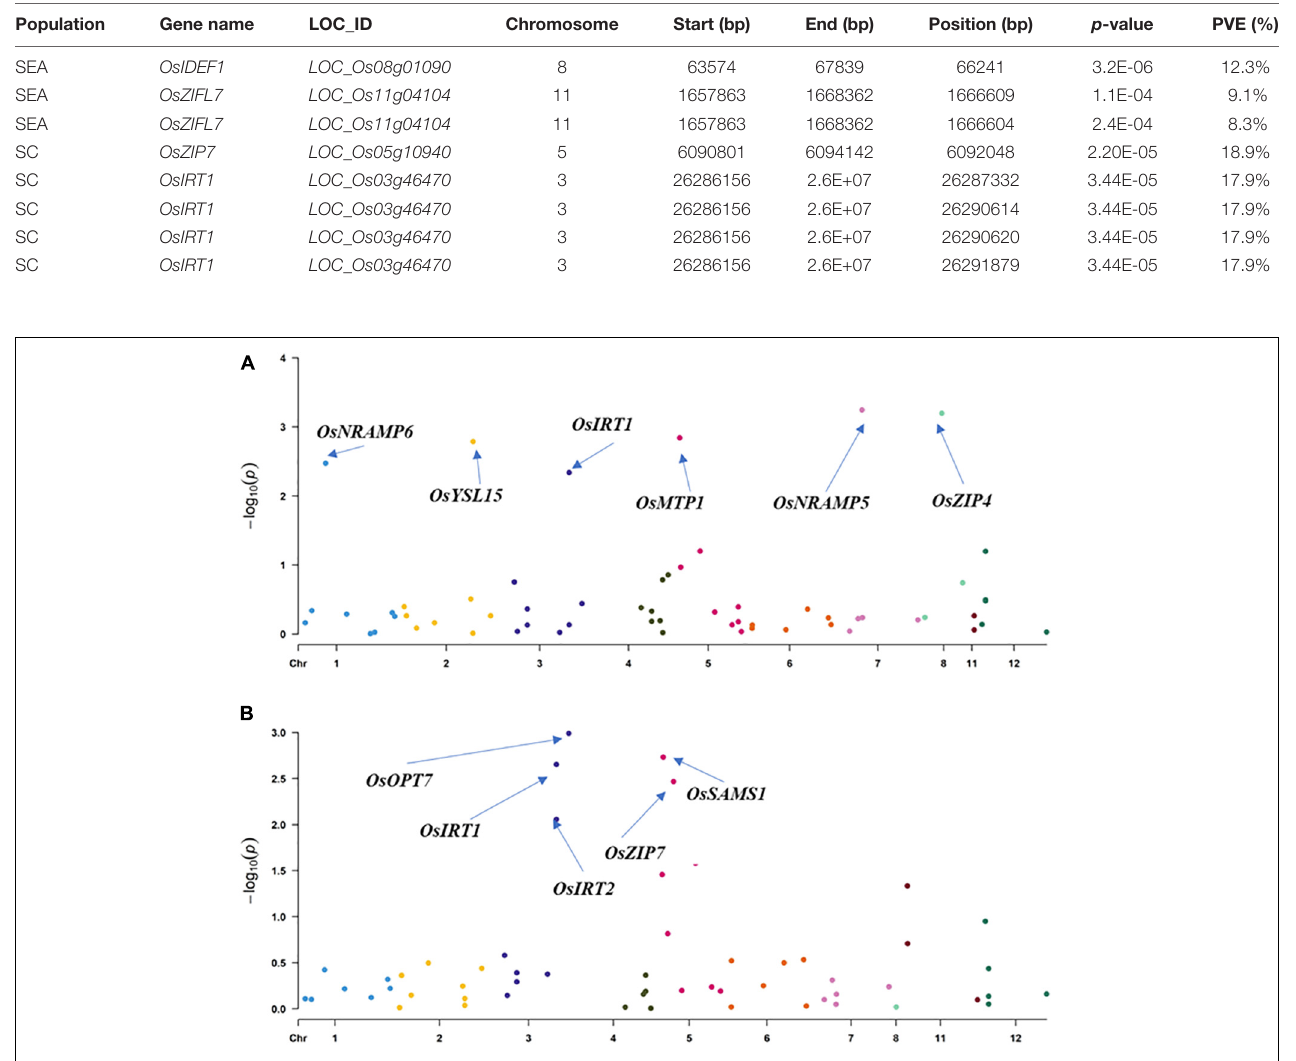
FIGURE 3 | Association analysis for grain Zn content by Hap-GWAS in SEA and SC panel. (A) SEA panel and (B) SC panel.